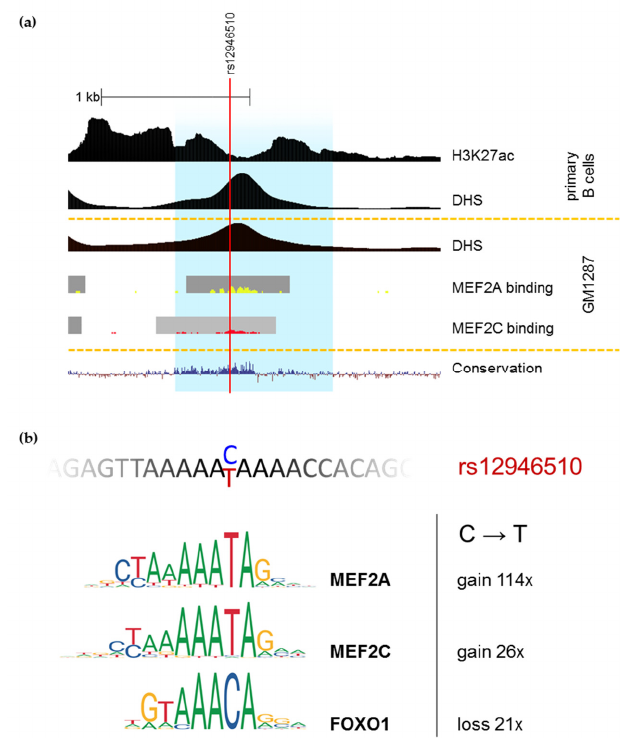
Figure 3. Polymorphism rs12946510 alters MEF2A/C and FOXO1 binding sites. ( a ) University